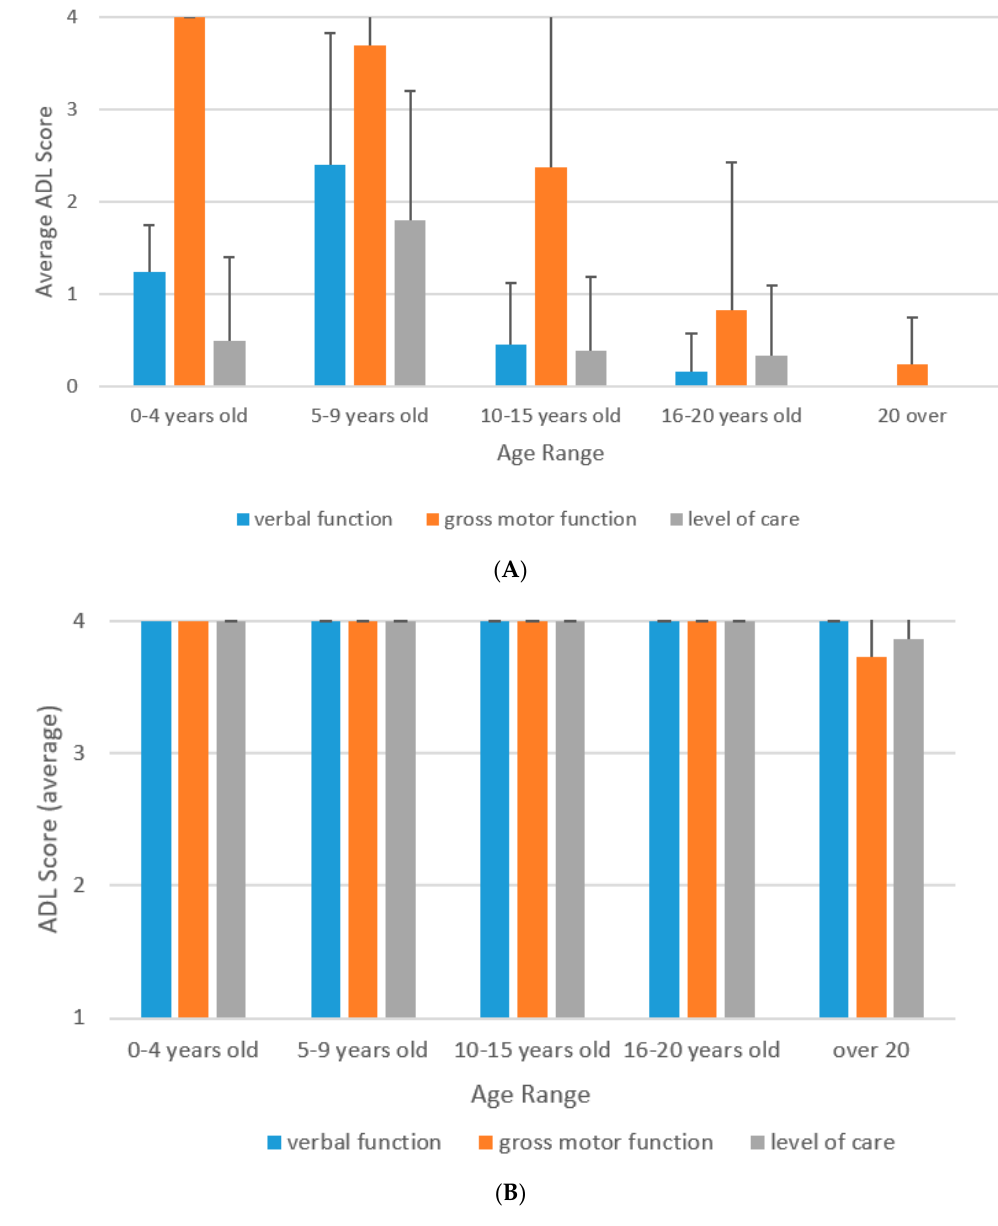
Figure 1. ( A ) ADL scores for untreated severe MPS II patients. ( B ) ADL scores of untreated attenuated MPS II